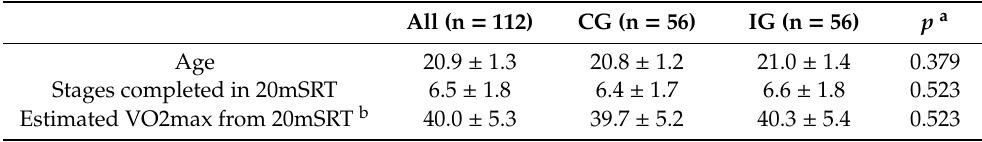
Table 2. Baseline characteristics of the college students.